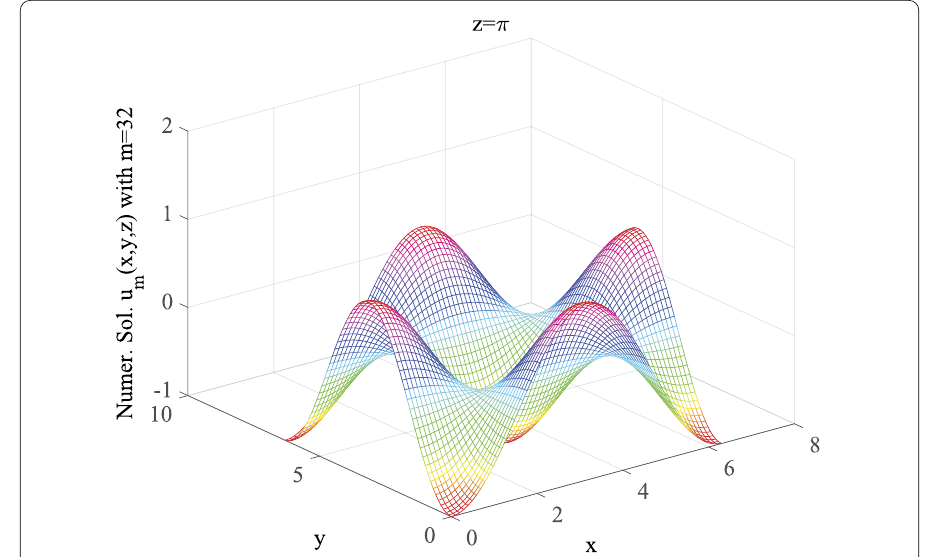
Figure 2 The approximate solution u ( x , y , π ) with m = 32 for Example 6.3